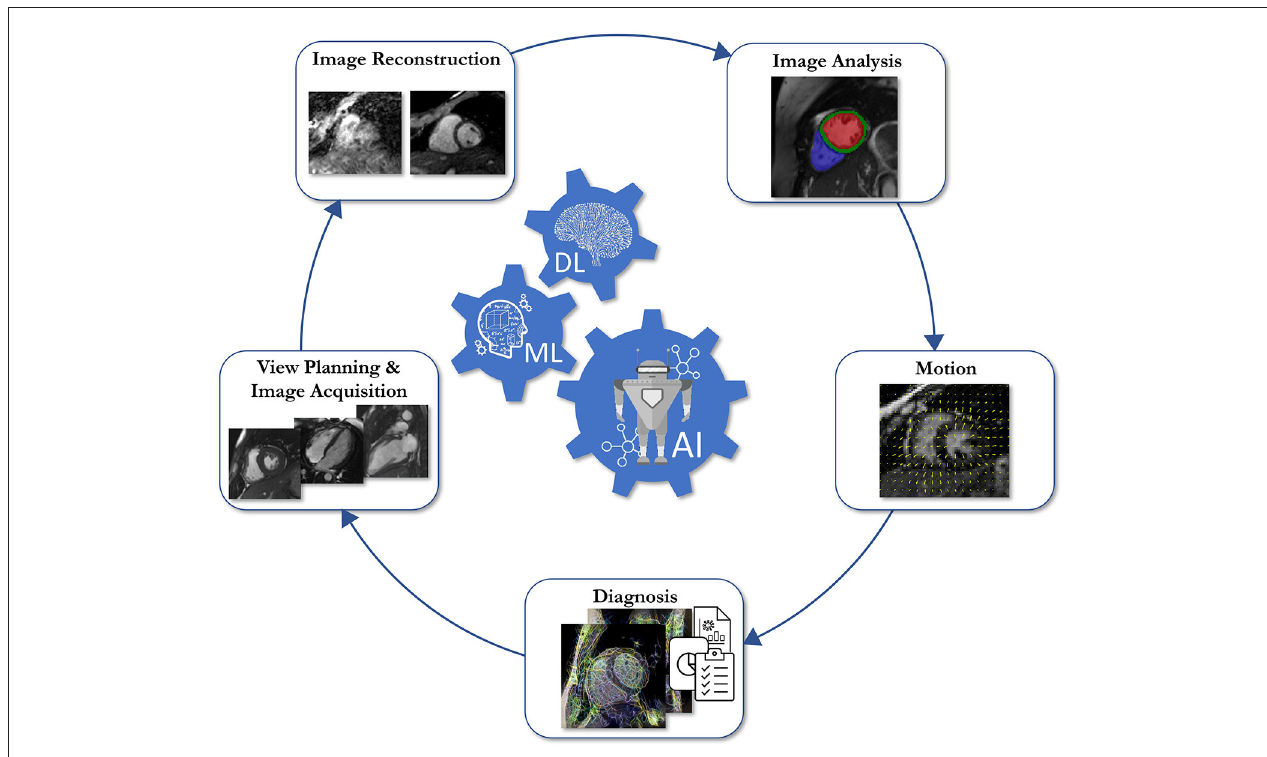
FIGURE 14 | Schematic overview of the five areas in which Artificial Intelligence (AI)/Machine Learning (ML)/Deep Learning (DL) assisted operations can support the clinical